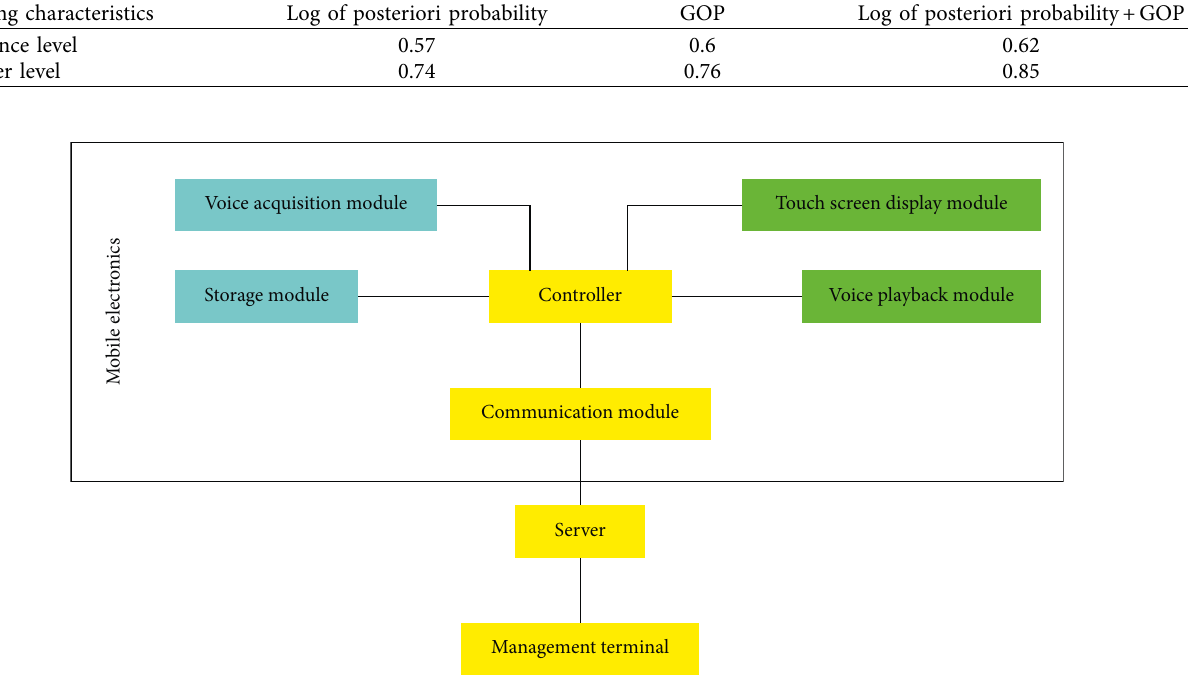
Figure 5: The system framework. Table 3: The manual scoring